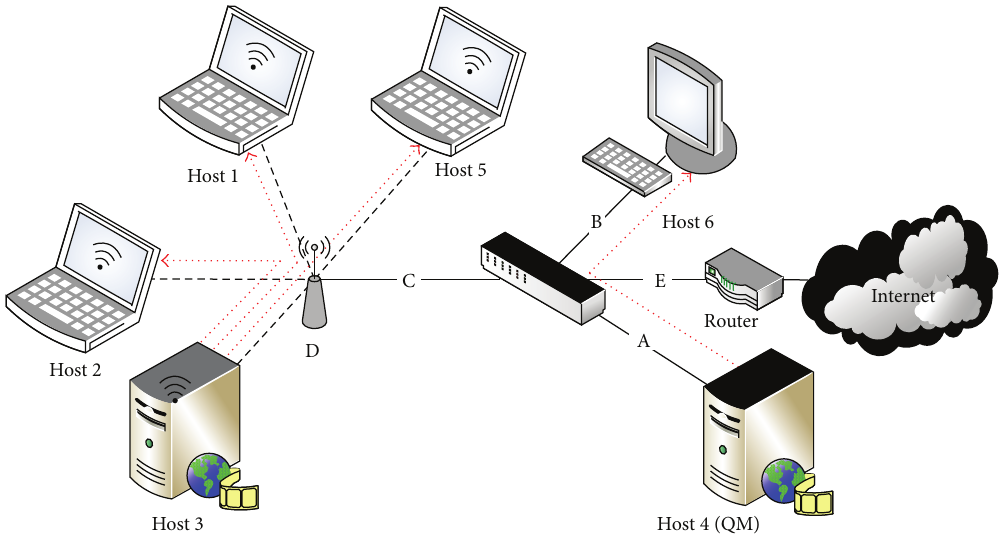
Figure 12: QoSiLAN evaluation